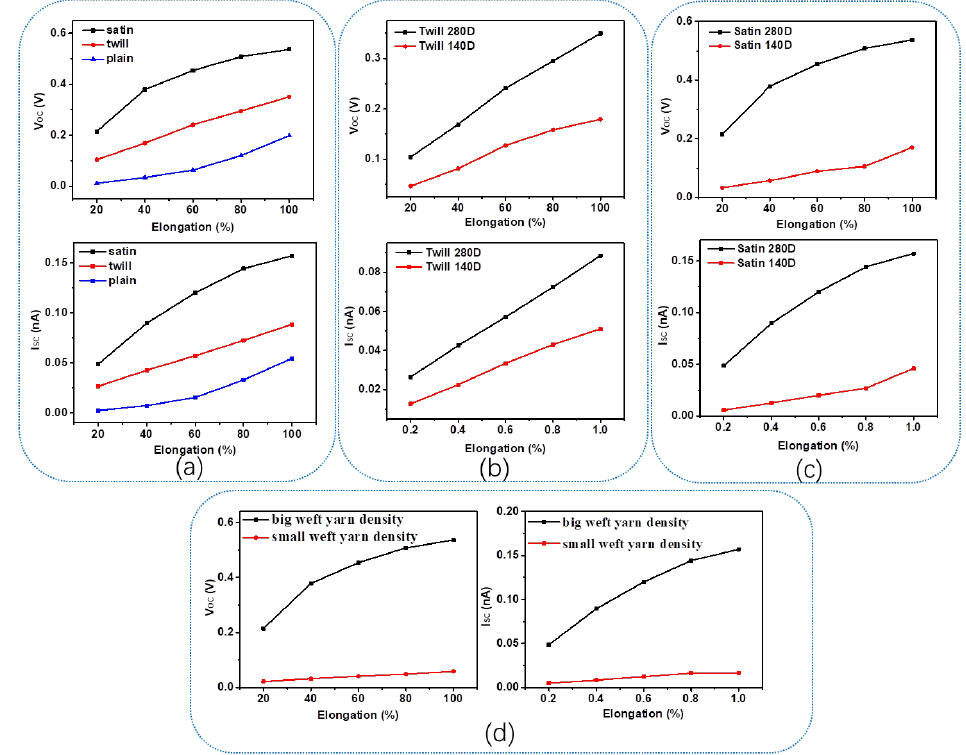
Figure 7. ( a ) The outputs comparison of satin, twill, and plain structures; The electrical output performances comparison between different SWF-TENGs; ( b ) Twill structure fabricated by the PA conductive yarn, including 280D and 140D; ( c ) Satin structure fabricated by the PA conductive yarn, including 280D and 140D; ( d ) SWF-TENGs with different weft yarn densities.